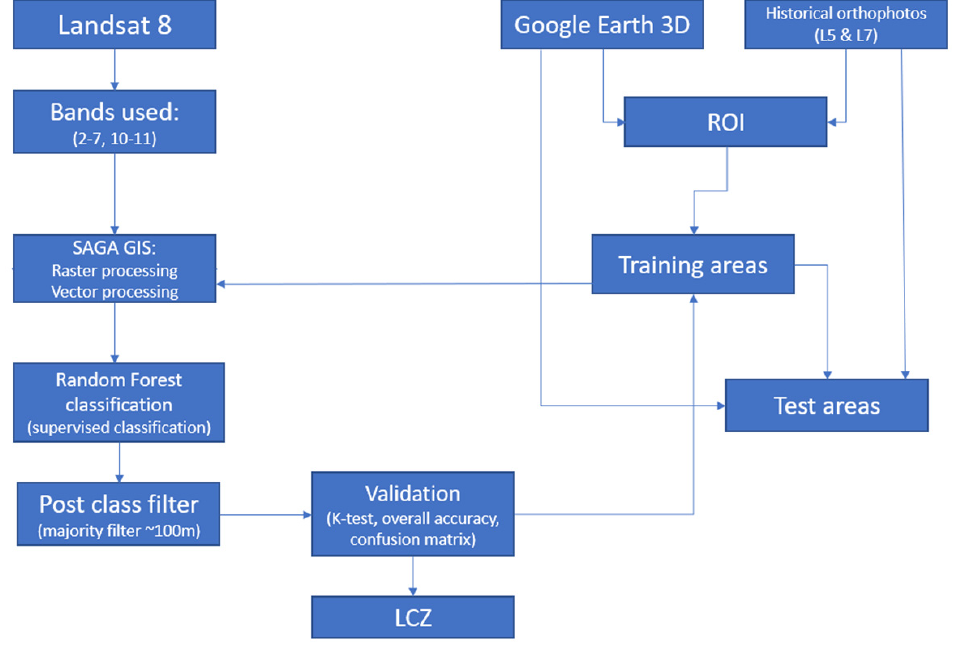
Figure 3. WUDAPT Figure 3. WUDAPT workflow.